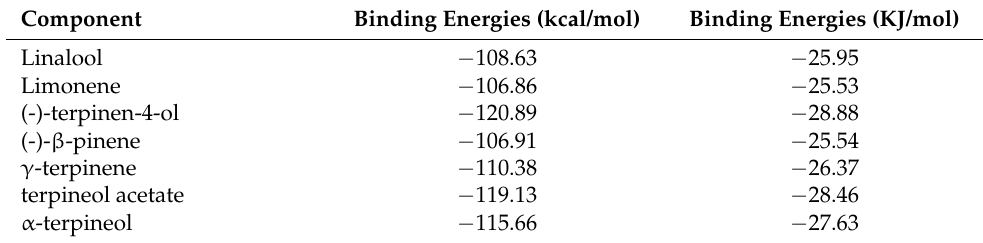
Table 4. Molecular docking binding